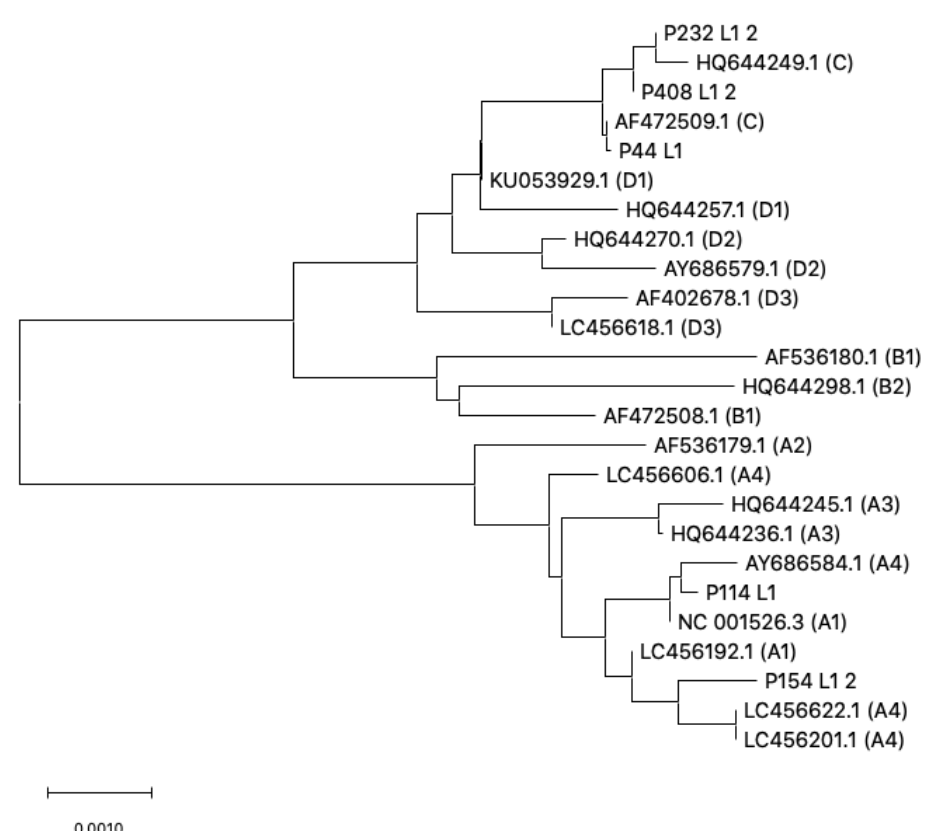
Figure 4. Evolutionary relationships of HPV16 lineages/sublineages in Kinshasa based on L1 region. The evolutionary history was inferred using the Neighbor-Joining method [37]. The tree is drawn to scale, with branch lengths in the same units as those of the evolutionary distances used to infer the phylogenetic tree. The evolutionary distances were computed using the Maximum Composite Likelihood method [38] and are in the units of the number of base substitutions per site. The analysis involved 25 nucleotide sequences (20 reference strains from GenBank and 5 new sequences from this study). Codon positions included were 1st + 2nd + 3rd + Noncoding. All positions containing gaps and missing data were eliminated. There were a total of 1518 positions in the final dataset. Evolutionary analyses were conducted in MEGAX [35,36].